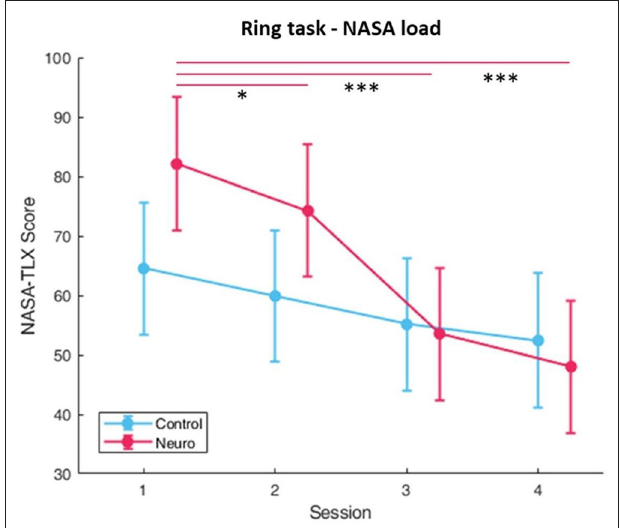
FIGURE 13 | Subjective workload calculated by sum of NASA-TLX self-reports for rings task. A significant condition by session interaction was found, and only the neuroadaptive group had significant decreases in self-reported workload (whiskers are SEM, * p < 0.05, *** p < 0.001).